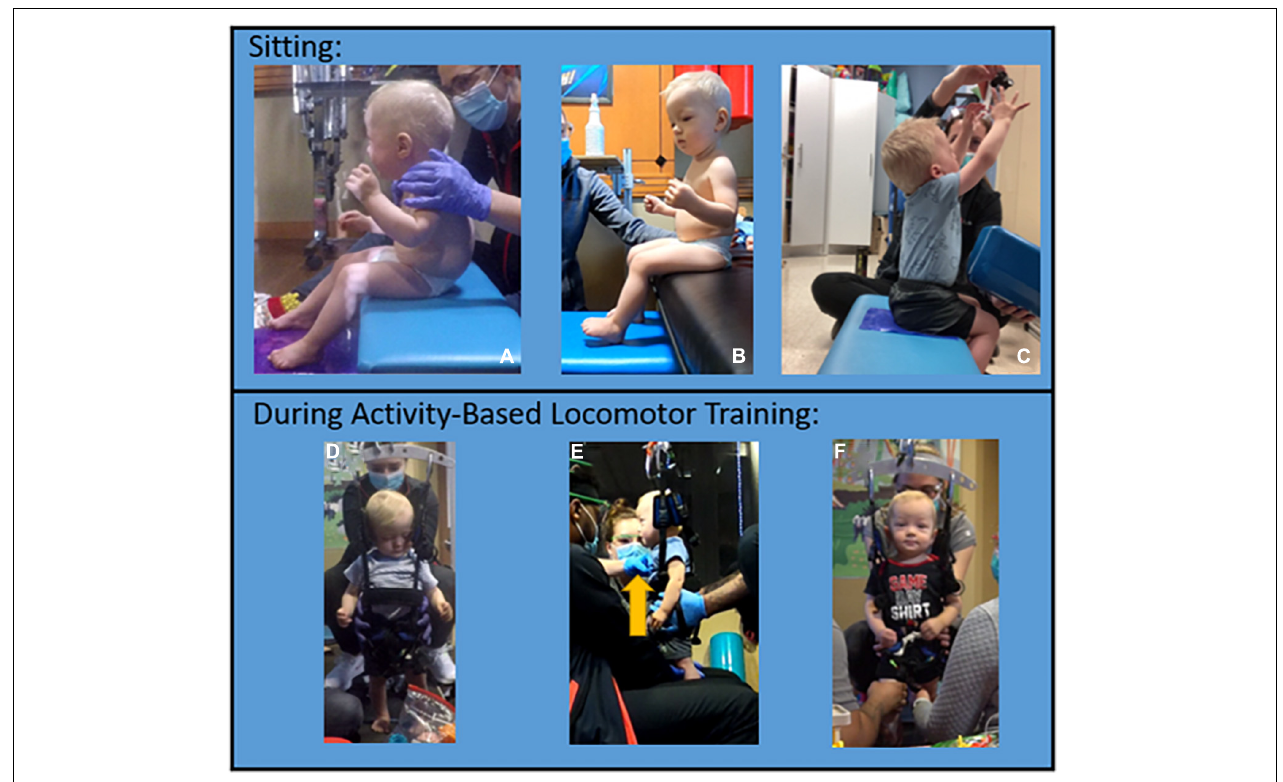
FIGURE 3 | Trunk control progression. Sitting trunk control progression. (A) Initial evaluation: significant posterior pelvic tilt with kyphosis, unable to sit with or without upper extremity support. (B) Session 73: improved trunk and pelvic posture, the patient is able to maintain independently without upper extremity support. (C) Session 129: the patient can reach overhead with bilateral upper extremities to grasp object with maintenance of posture and balance. Trunk control progression during AB-LT: (D,E) . Initially, the harness strap was required at low ribs to assist with upright trunk posture and additional facilitation at the trunk was required for the patient to stay upright (see arrow in panel E ). (F) Progression noted by removal of trunk strap during dynamic stepping activity with patient maintaining trunk